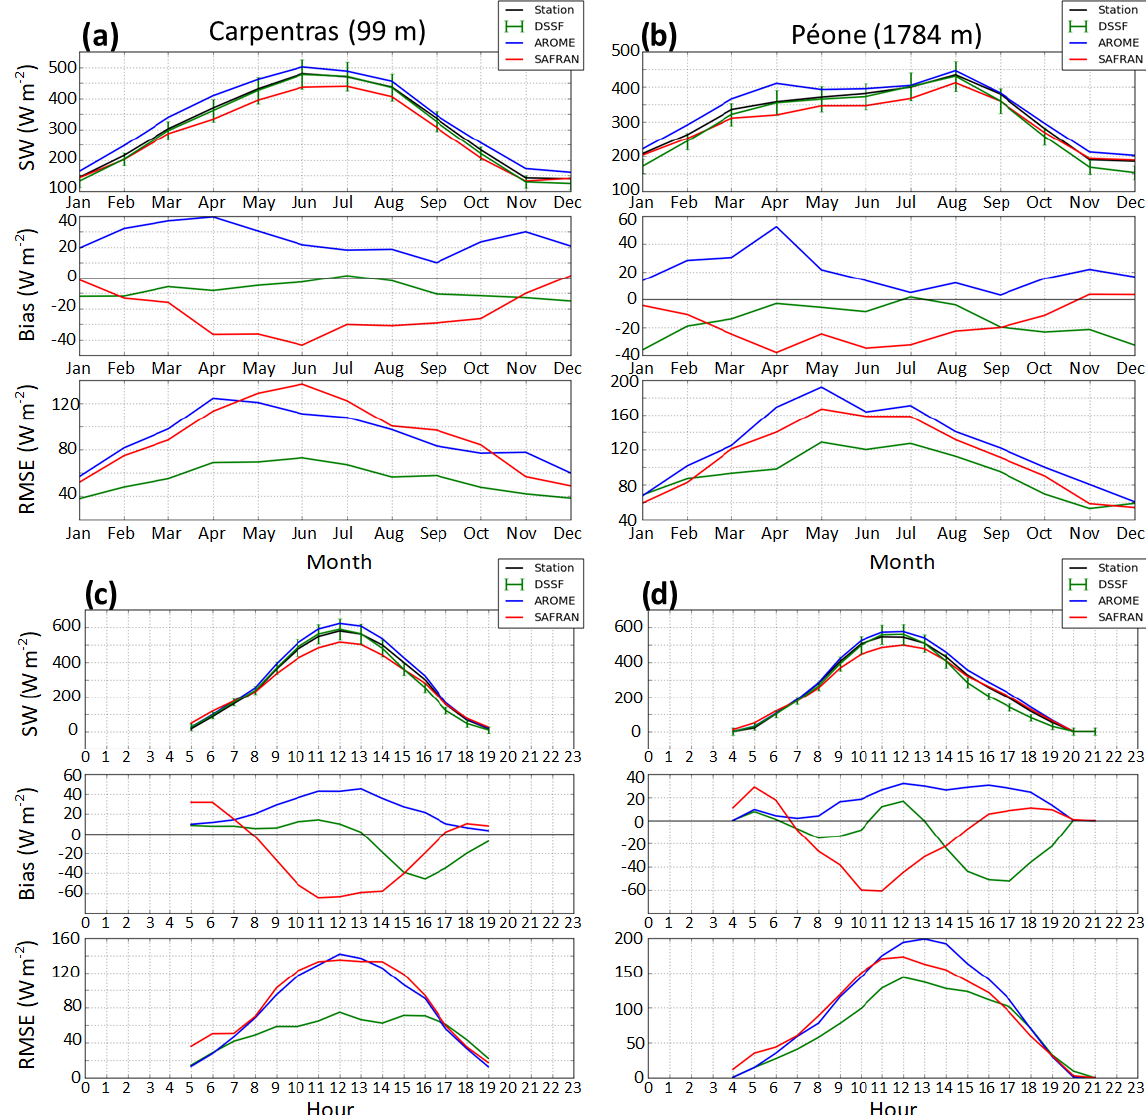
Figure 4. Mean yearly cycles of SW ↓ irradiance products (DSSF in green, AROME in blue, SAFRAN in red), ground measurements (in black), bias and RMSE over the 2010–2014 period at (a) Carpentras and (b) Péone. Mean daily cycles of the same products, bias and RMSE over the 2010–2014 period at (c) Carpentras and (d)